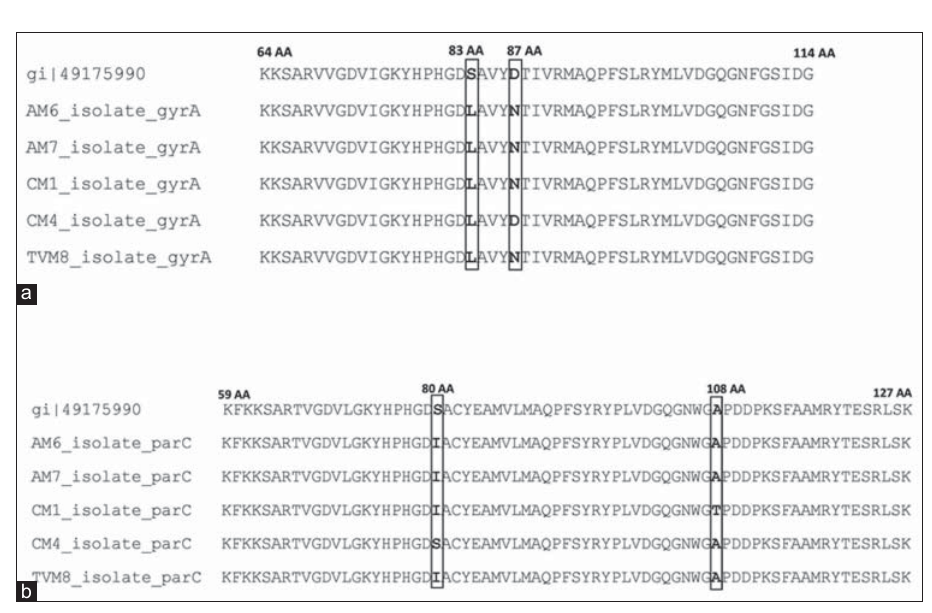
Figure-2: Amino acid variation of (a) gyrA gene and (b) parC gene of five Escherichia coli isolates under this study and wild type E. coli reference strain (49175990) available in GenBank .